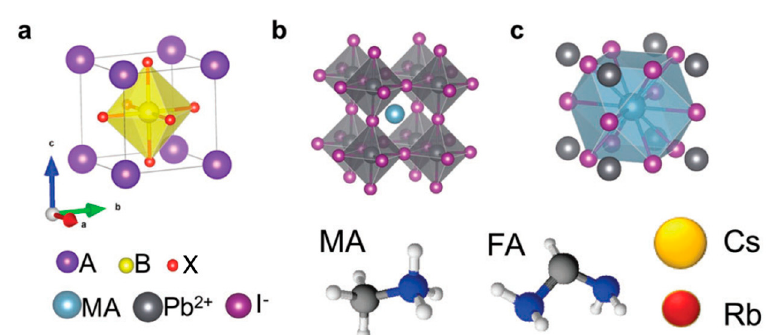
Figure 1. Representation of the typical components of lead perovskites and the typical perovskite crystal structure, viewed in three different ways. ABX 3 with A components being methylammonium (MA), formamidinium (FA) or Cs(I) or Rb(I), the B = Pb(II). The X can be iodide (I − ), bromide or chloride. Note that the octahedral coordination around Pb(II) can be displayed centrally ( a ) or the MA can be shown centrally ( b ). In ( c ) the square unit cell is shown with MA in the center. Reproduced (and adapted) with permission from Energy Environ. Sci. 2017 , 10(3) , 710–727, Reference [2].